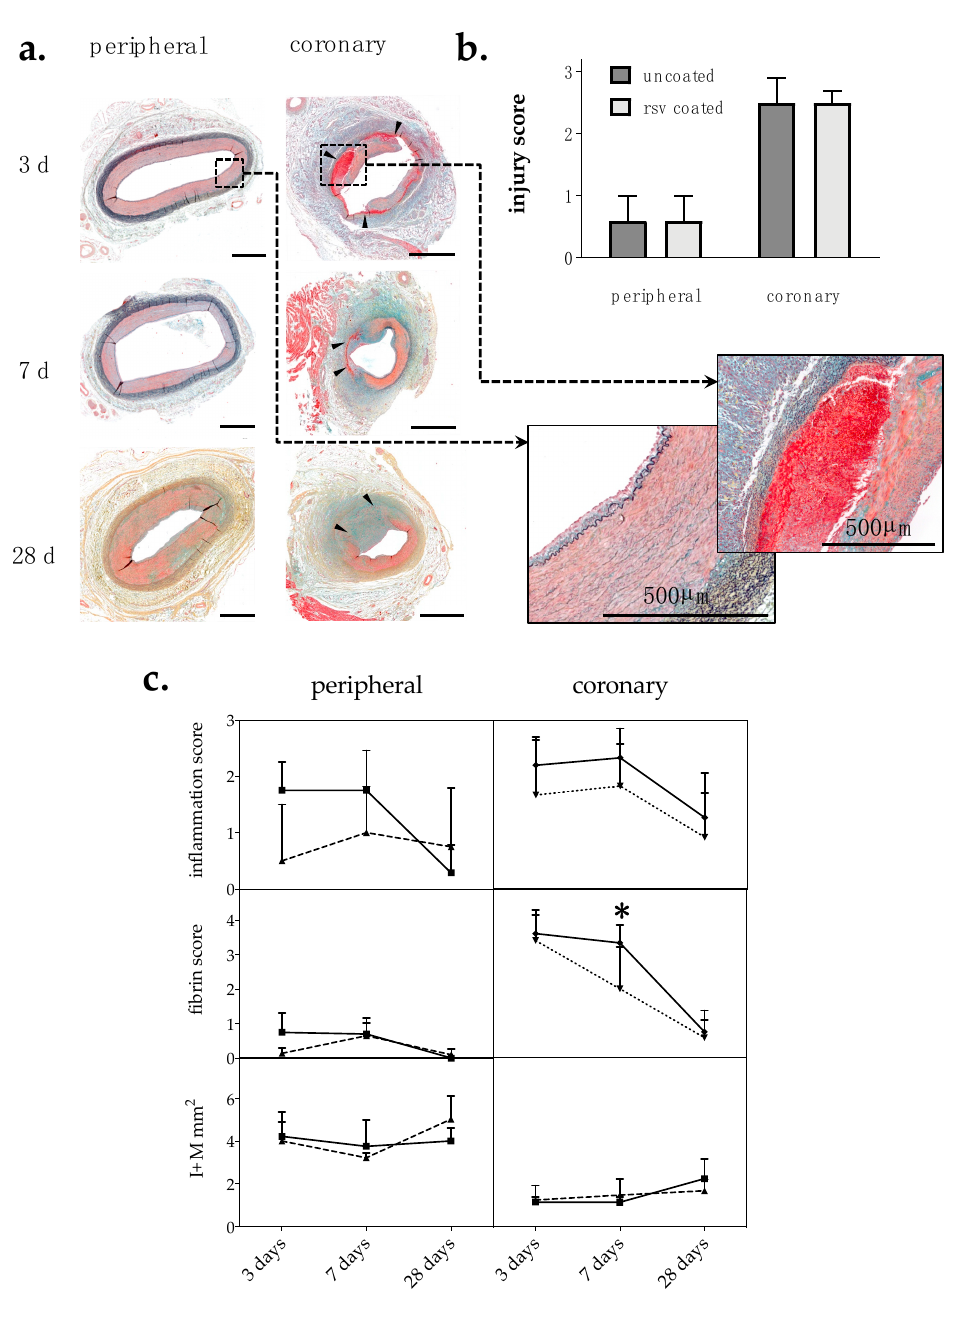
Figure 1. ( a ) Movat pentachrome-stained cross sections of representative coronary and peripheral arteries 3 days, 7 days and 28 days post injury treated with uncoated balloon catheters. Blue: Ground substance and degenerated tissue; red: Muscle; bright red: Fibrin; black: Elastic fiber. Bar = 1 mm. Arrowheads indicate severe injury with media rupture and dissection. ( b ) Injury score of peripheral and coronary arteries; n ≥ 22 coronary; n ≥ 15 peripheral. ( c ) Histological and morphometric analyses of Movat pentachrome-stained vessel sections. One cross section each from three section levels per vessel were analyzed. I + M: Intima–media area. rsv: resveratrol. n ≥ 4 peripheral; n ≥ 5 coronary; n : Number of arteries; values are mean ± SD; p -value determined by Mann–Whitney test; * p ≤ 0.05.